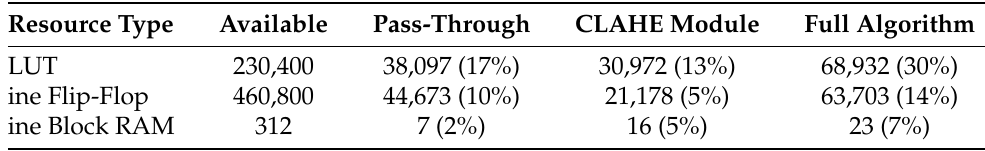
Table 2. The use of hardware resources for the CLAHE algorithm on the ZCU 104 board. Note a relatively low resource utilisation of our module. It consumes even less LUTs and Flip-Flops than basic video pass-through, which is needed to provide the input and output images. Therefore, our implementation can be used in combination with other hardware modules of the entire embedded vision system as it consumes only a small part of the available resources. The utilisation of DSP resources is not reported as our implementation of the CLAHE module uses none of them.